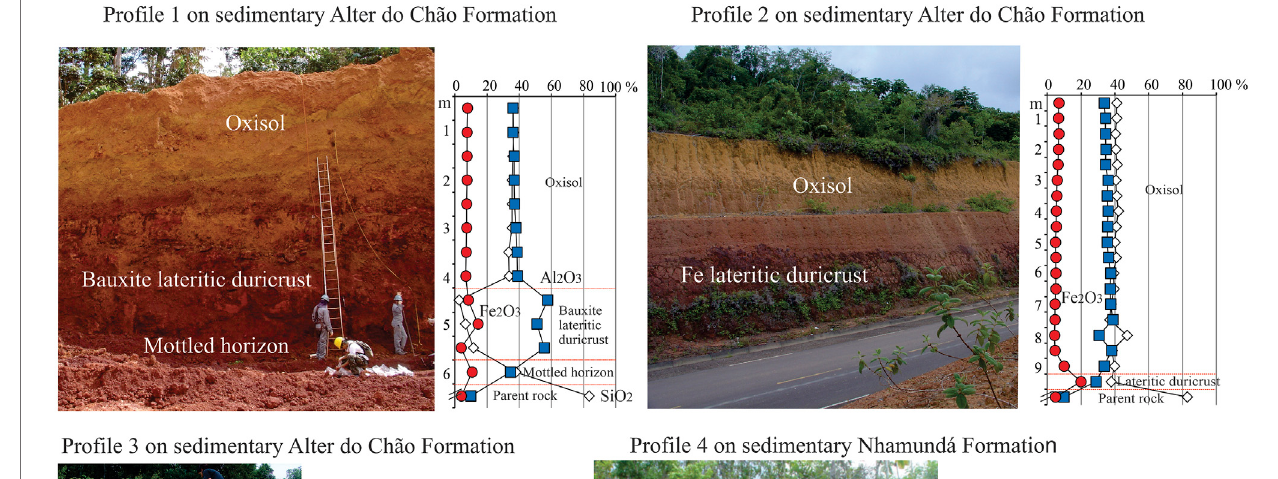
FIGURE2| Pro fi le structure showing thesampledhorizons and therespectiveplot ofSiO 2 , Fe 2 O 3 ,and Al 2 O 3 contents expressed asweight %alongthehorizons.